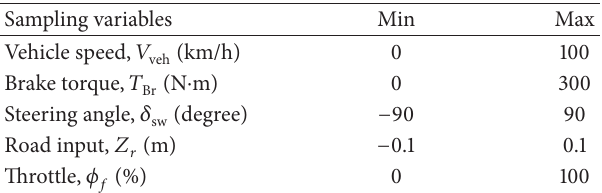
Table 2: Sampling inputs and their